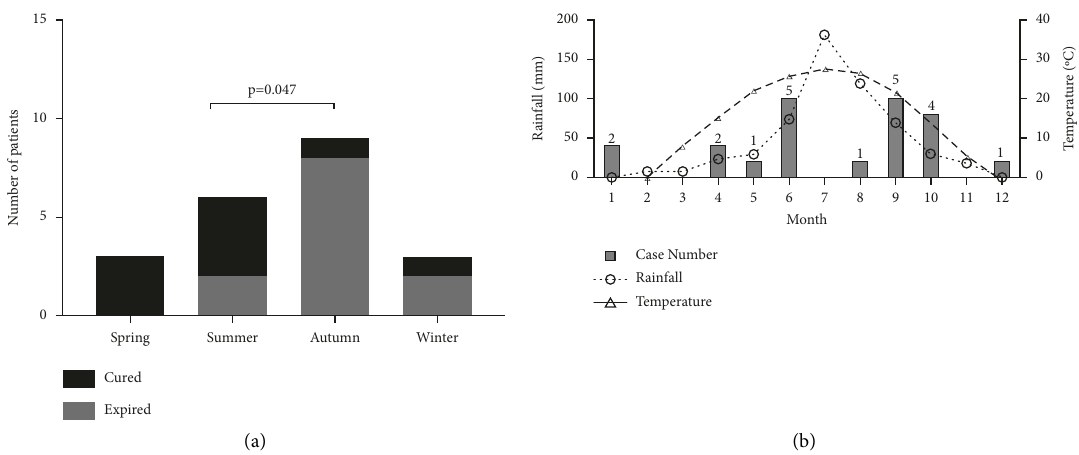
Figure 2: Seasonal distribution characteristics of the 21 cases. (a) Most of the cases show symptoms of infection in summer and autumn. Patients with onset in autumn had more mortality after 1 year ( p < 0 . 05). (b) The temperature and rainfall in Beijing in the last decade generally peaked in July, and most of the PM patients gathered around the peak after